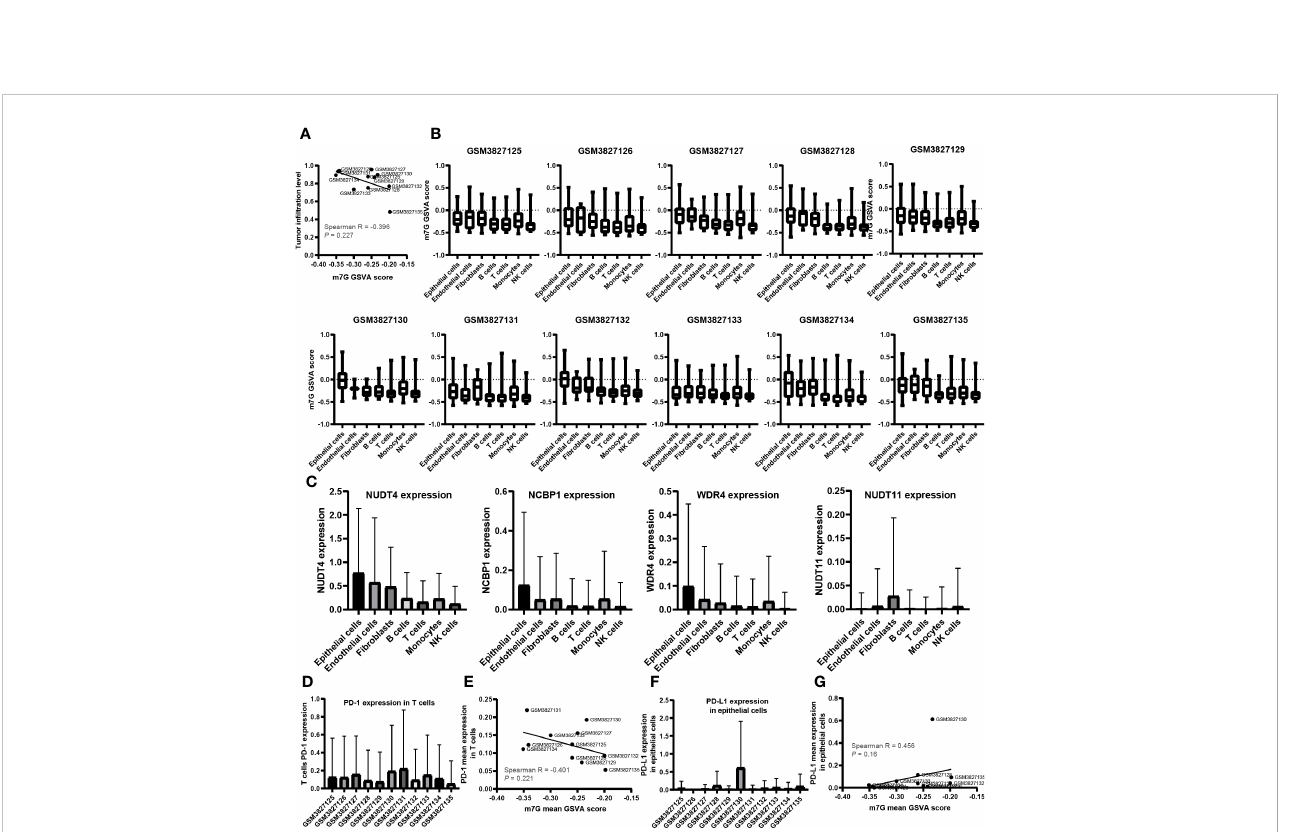
FIGURE 6 The relationship between N7-methylguanosine (m7G) GSVA scores and tumor immune in fi ltration cells. (A) The relationship between m7G mean GSVA scores and tumor immune in fi ltration levels. (B) m7G mean GSVA scores in different cell types and different samples. (C) The expression level of Cox independent risk factors in different cell types. (D) PD-1 expression of T cells in different samples. (E) The relationship between m7G mean GSVA scores and T cell mean PD-1 expression. (F) PD-L1 expression of epithelial cells in different samples. (G) The relationship between m7G mean GSVA scores and epithelial cell PD-L1 mean expression. GSVA: Gene set variation analysis; PD-1: Programmed cell death 1; PD-L1: Programmed cell death 1 ligand